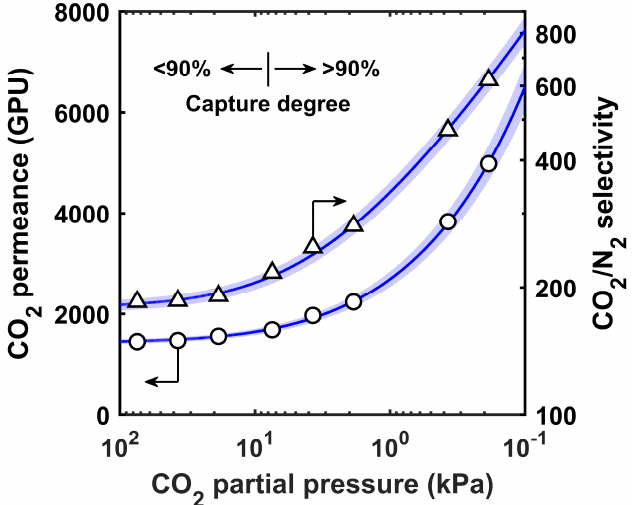
Figure 3. Increasing CO 2 permeance and CO 2 /N 2 selectivity with a decreasing partial pressure of the CO 2 of the benchmark FTM as reported by Han and Ho [38] . The best fits and uncertainties based the CO 2 of the benchmark FTM as reported by Han and Ho [38]. The best fits and uncertainties based on Equation (1) are shown as solid lines and blue shades, respectively. on Equation (1) are shown as solid lines and blue shades,